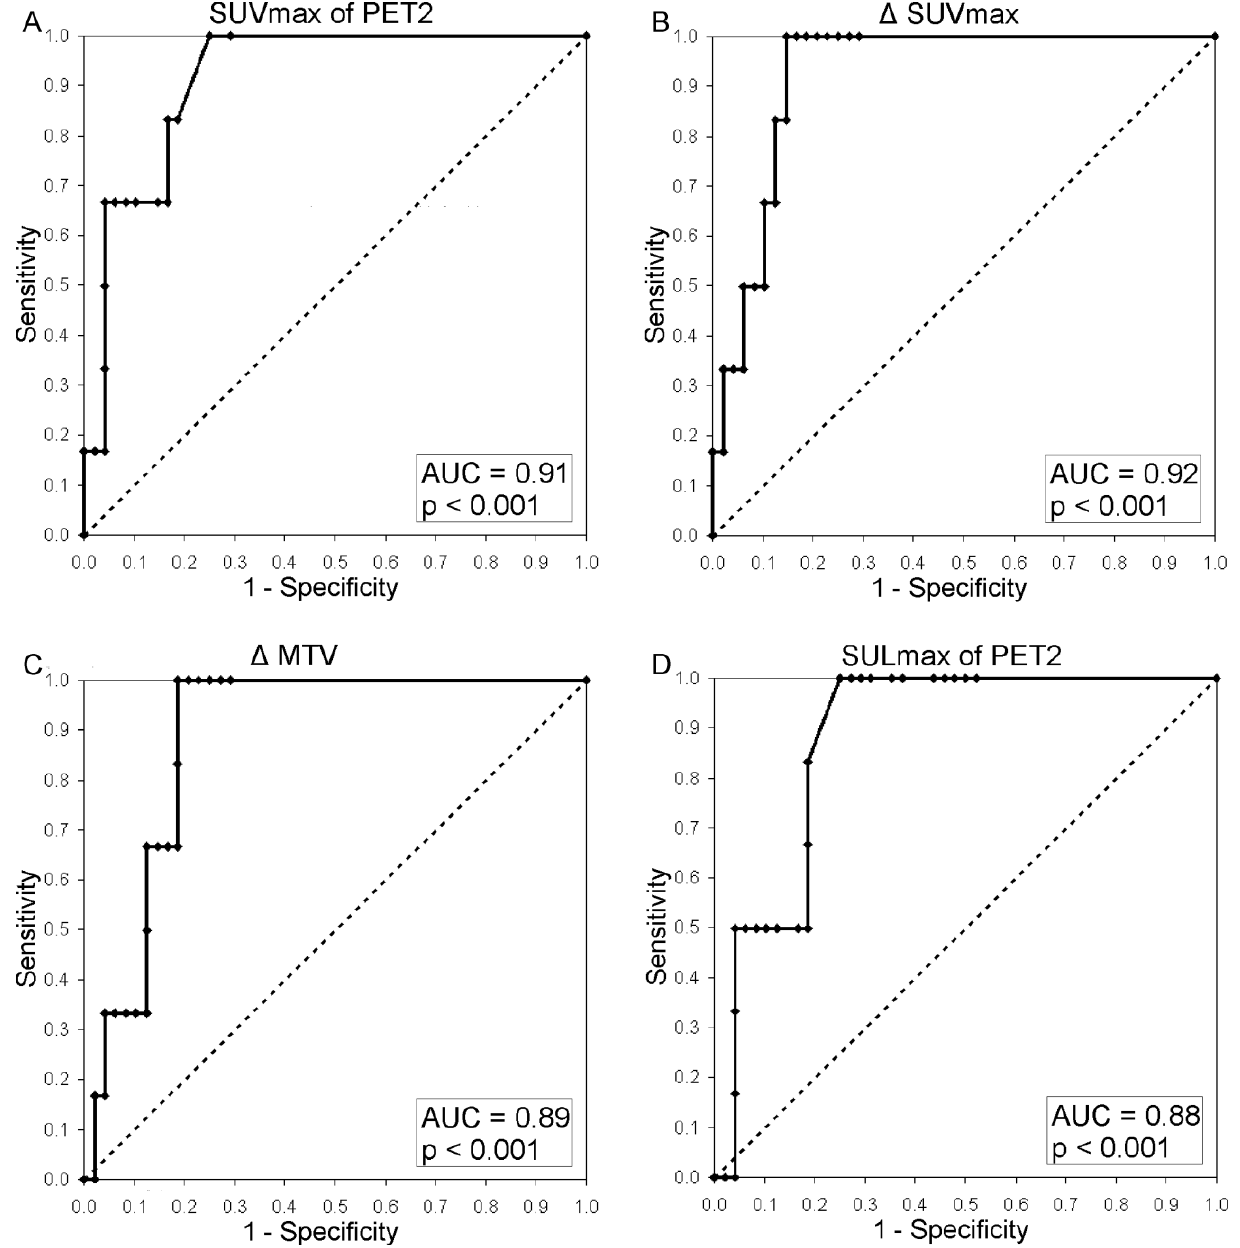
Figure 2. Receiver operating characteristics-curve of ( A ) SUVmax of PET2; ( B ) ΔSUVmax, ( C ) ΔMTV using a SUV of 2.5 as cut-off for PET1 and PET2 data; ( D ) SULmax of